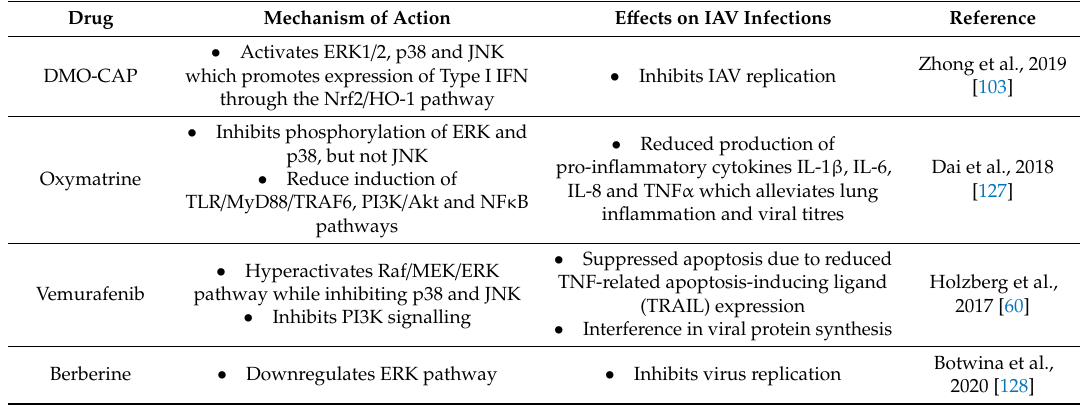
Table 1. Summary of potential drugs that act on the MAPK pathway against IAV